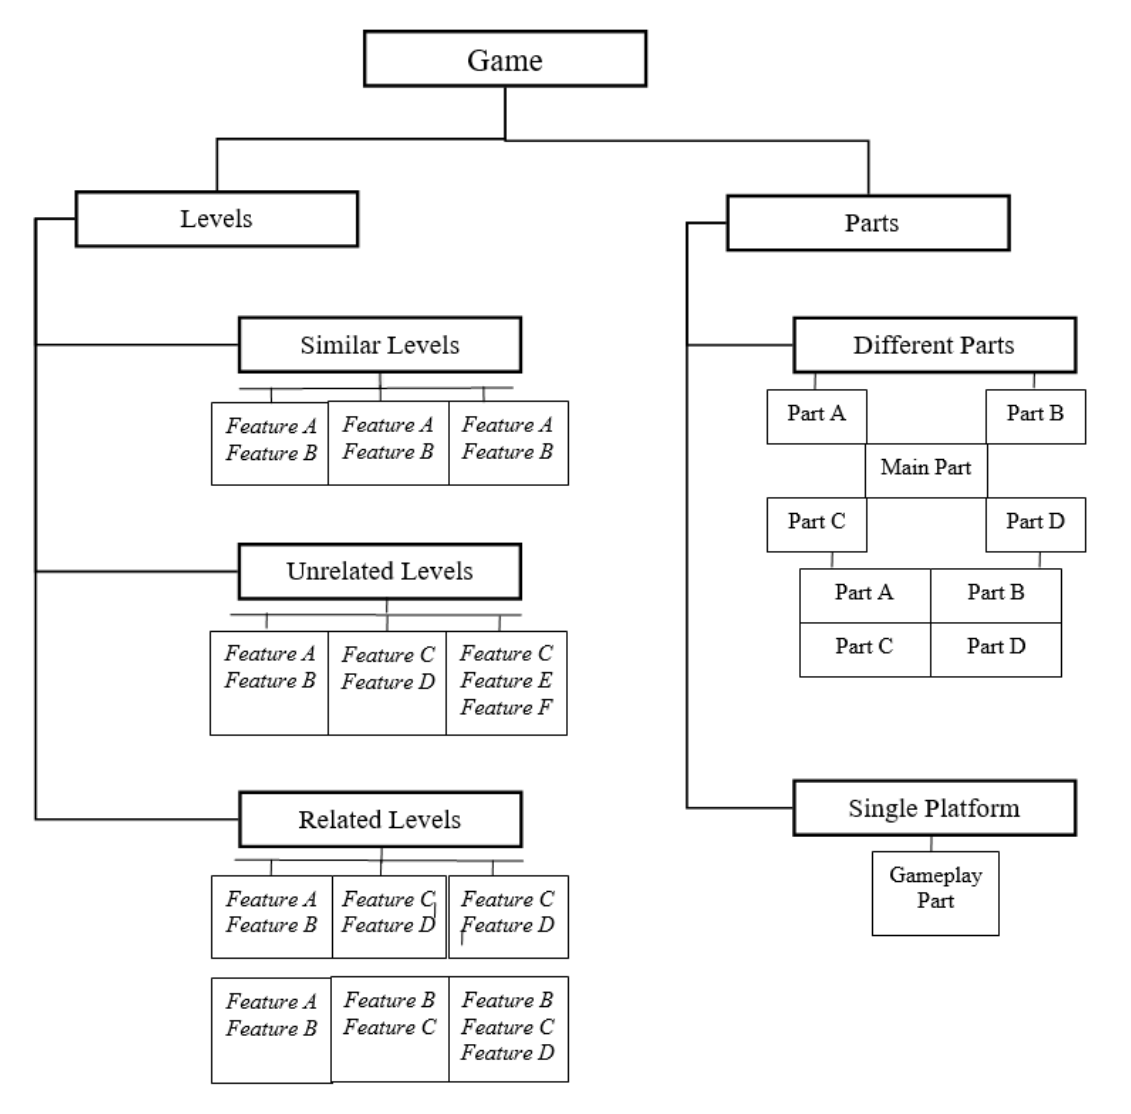
Figure 9. Structure of proposed taxonomy.